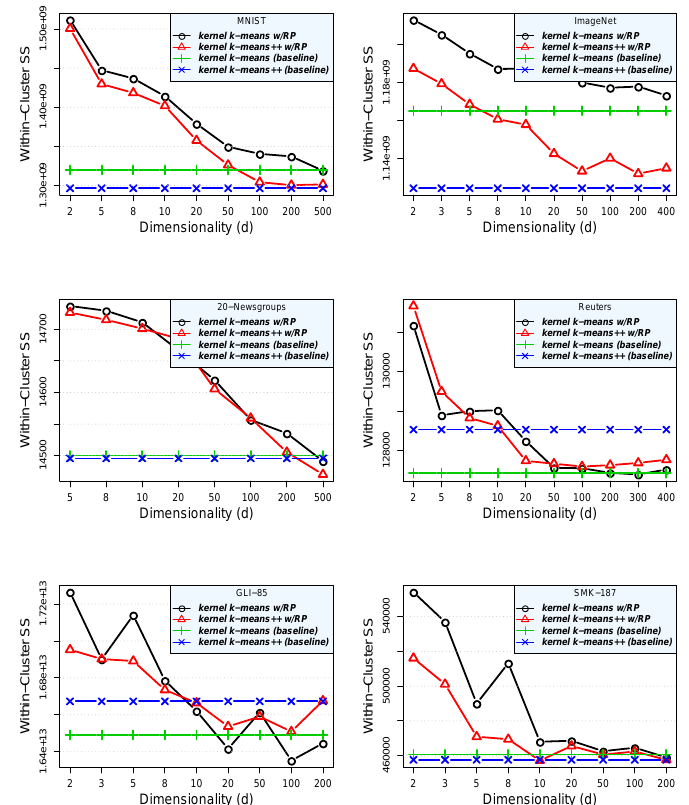
Figure 5. WCSS of approximation close to original kernel